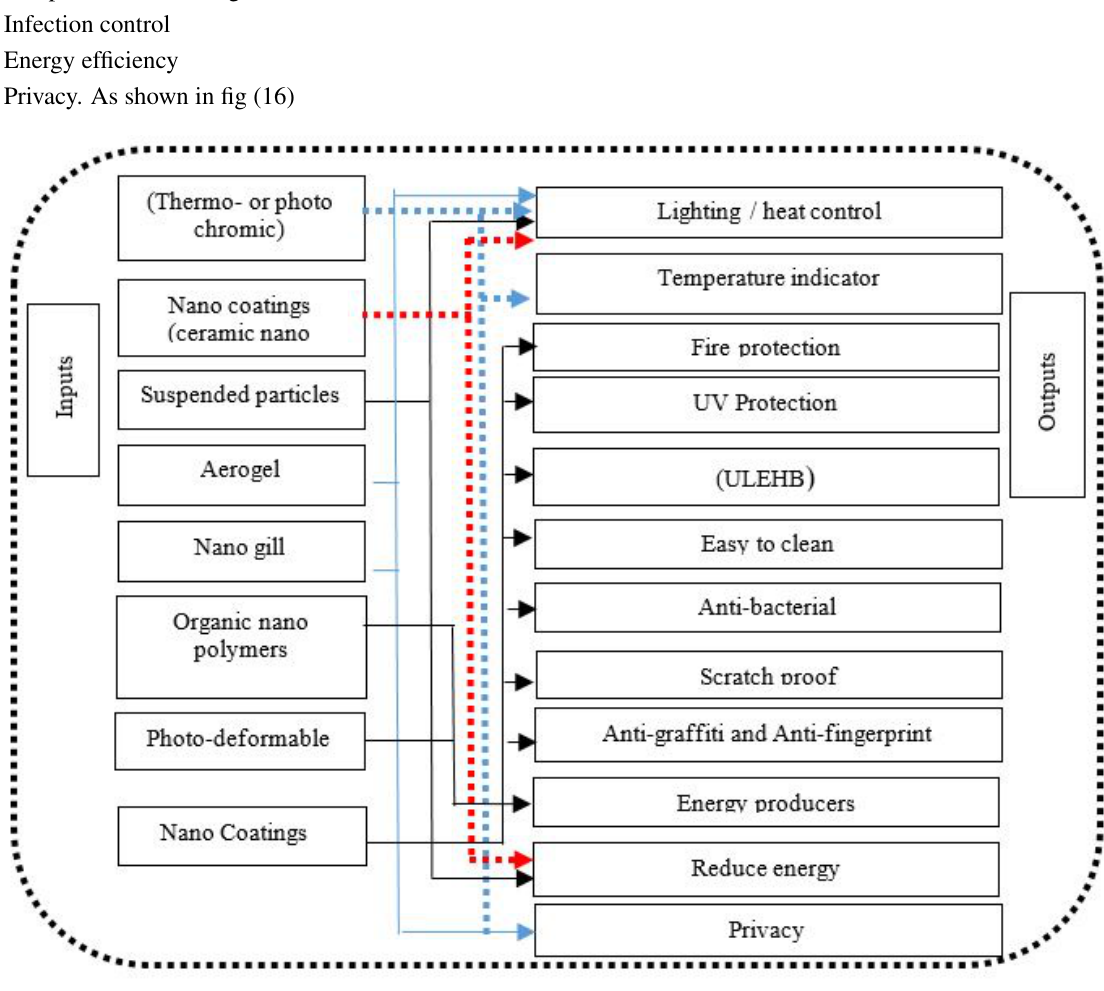
Figure 15. the inputs and outputs of smart and nanomaterials on the openings